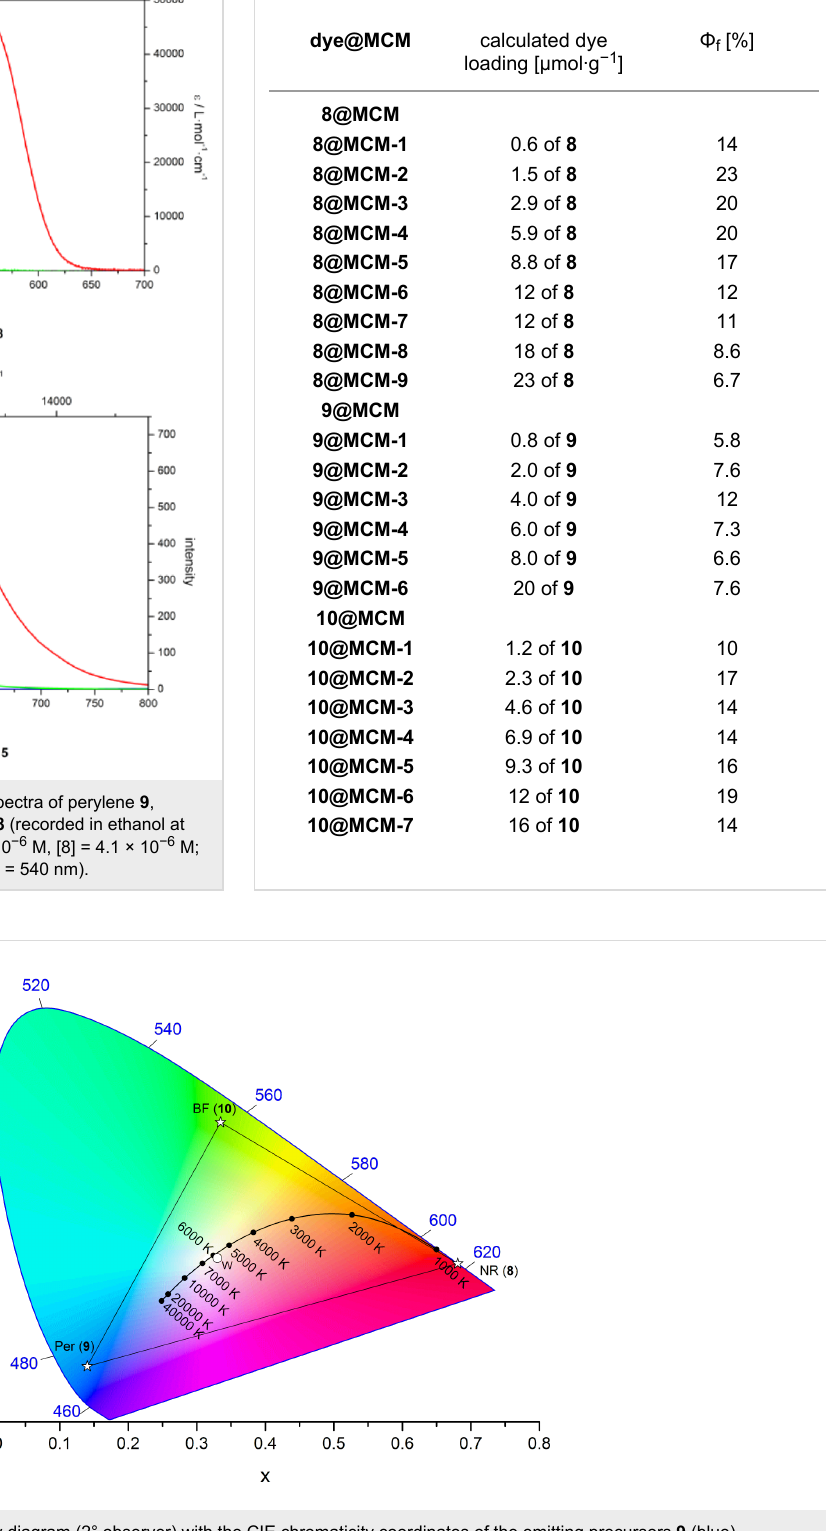
Table 1: Calculated dye loadings and solid state fluorescence quan- tum yields Φ f of grafted hybrid